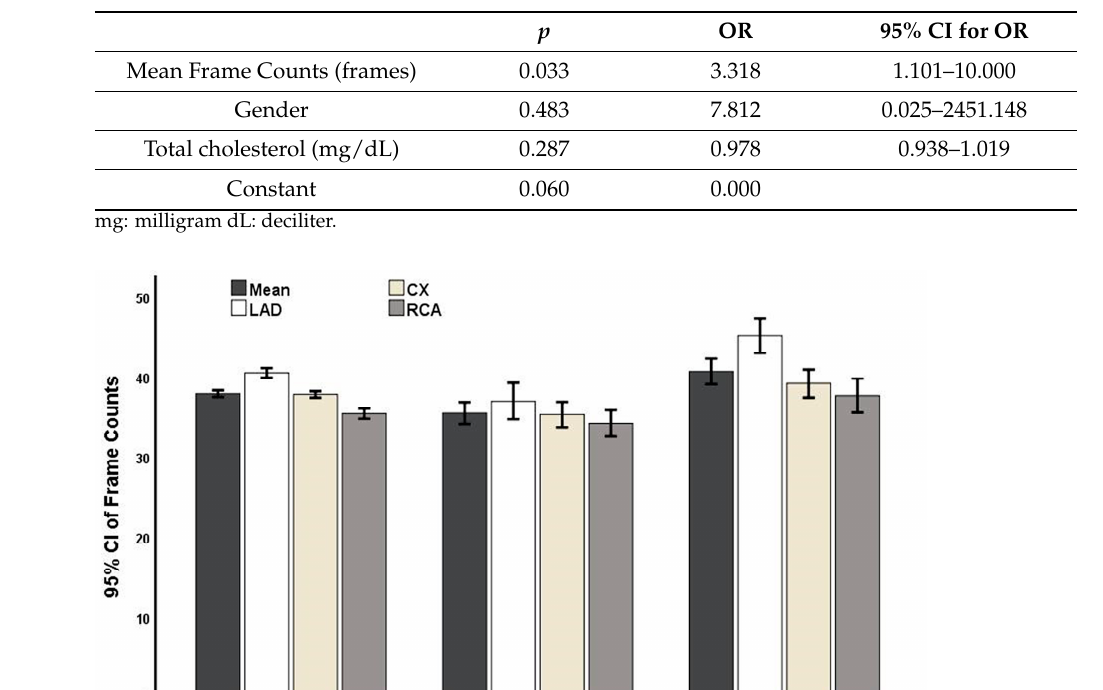
Table 4. Multiple logistic regression model for mortality caused by cardiovascular events in patients with CSF.